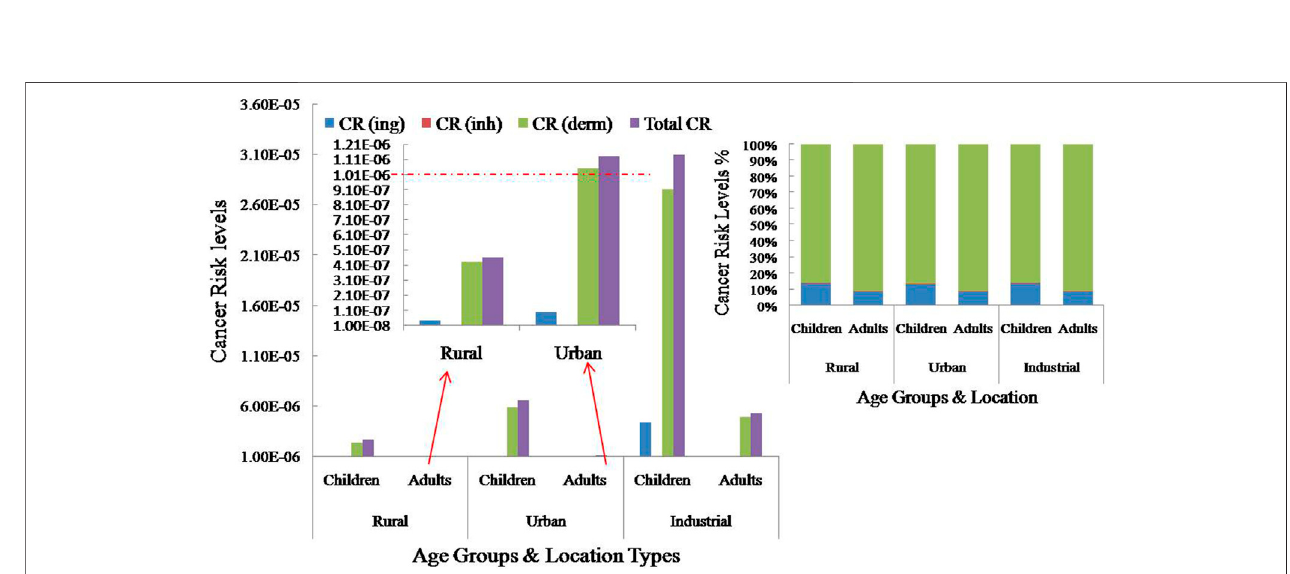
FIGURE 6 | Cancer risk from soil-bound PAHs in rural, urban, and industrial residential areas near the Ulsan industrial belt.